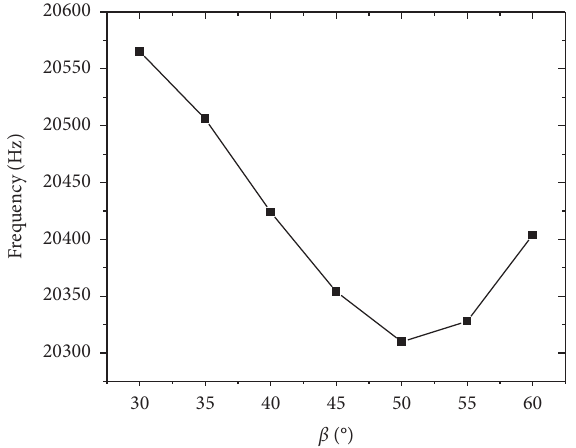
Figure 12: The effect of the sector angle β of the big end conical part of the compound horn on vibration